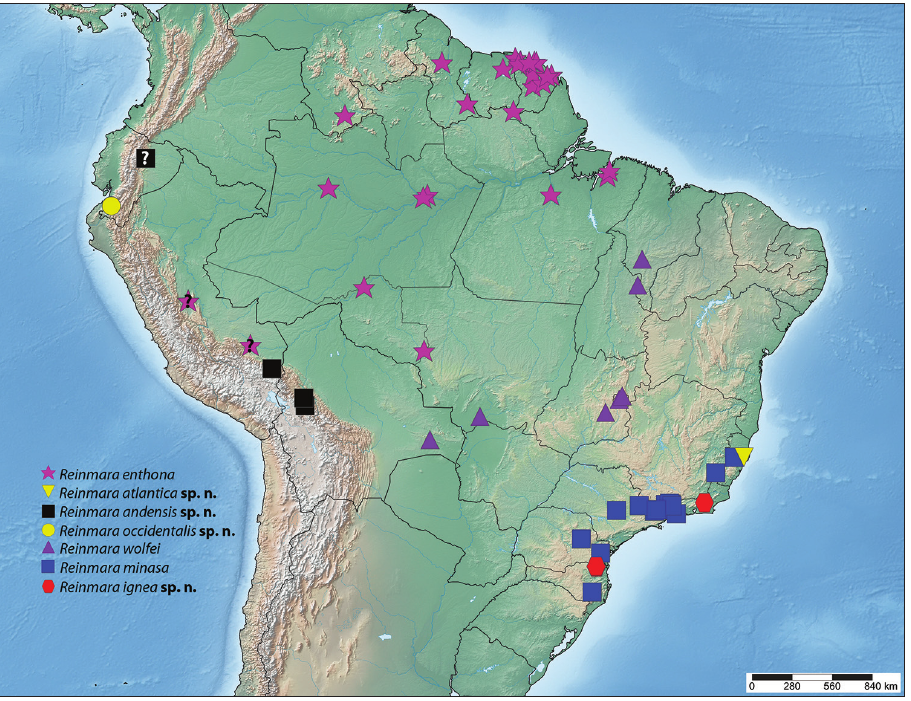
Figure 36. Known distribution of Reinmara